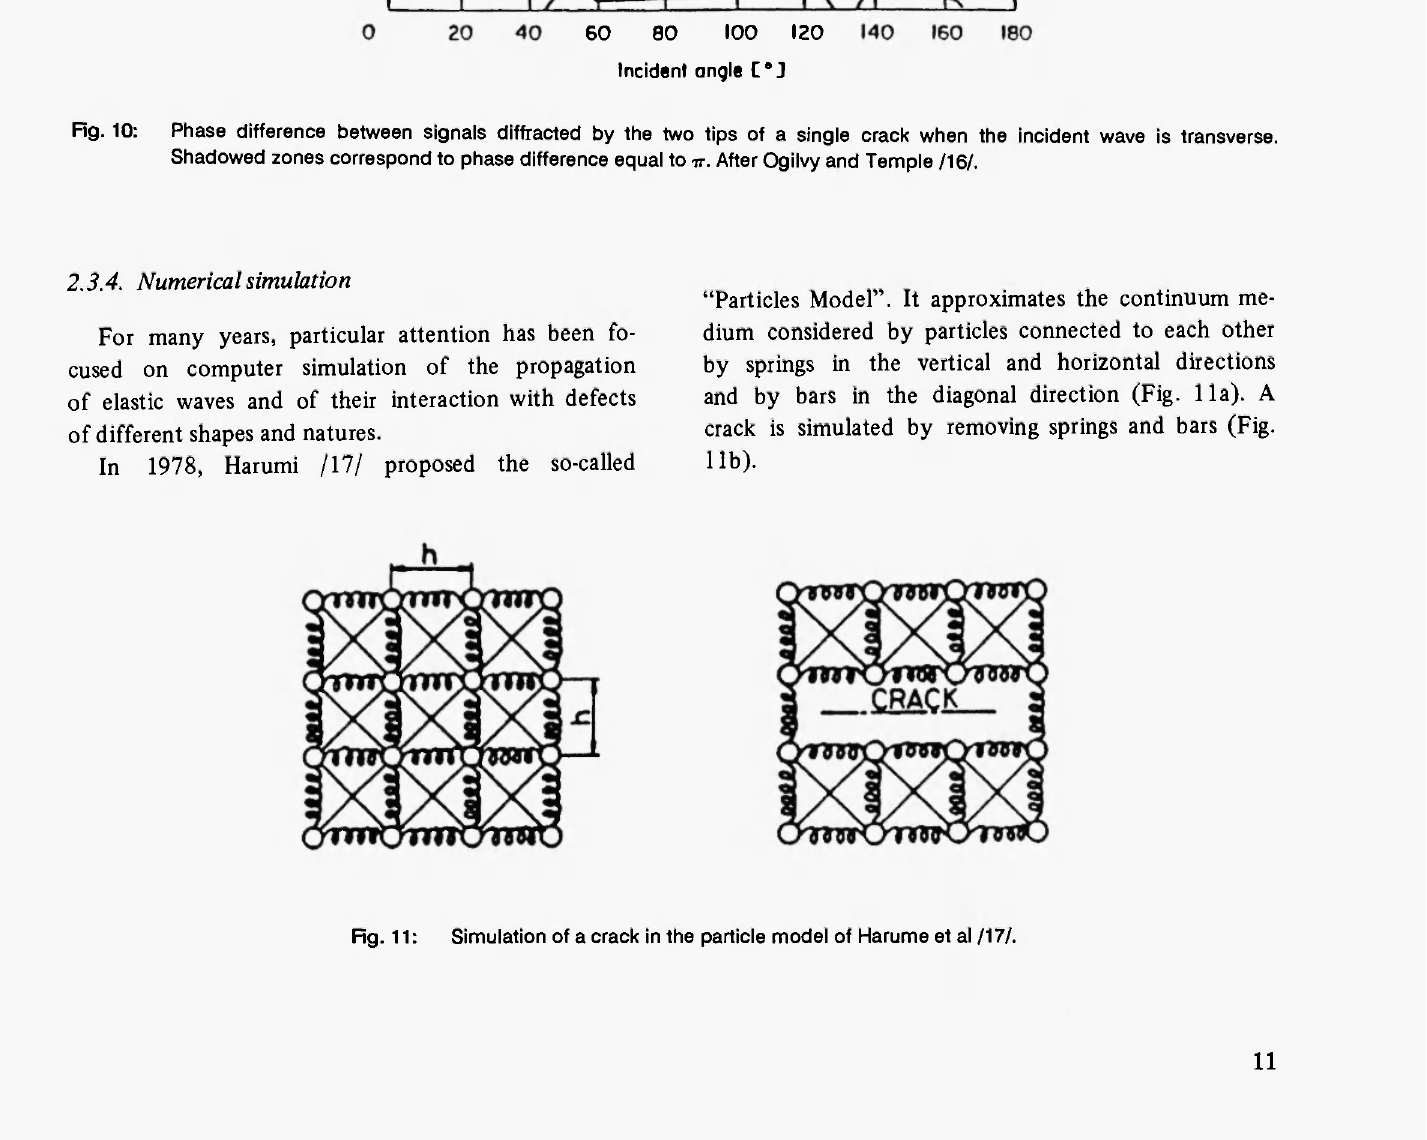
Fig. 10: Phase difference between signals diffracted by the two tips of a single crack when the incident wave is transverse. Shadowed zones correspond to phase difference equal to v. After Ogilvy and Temple /16/.